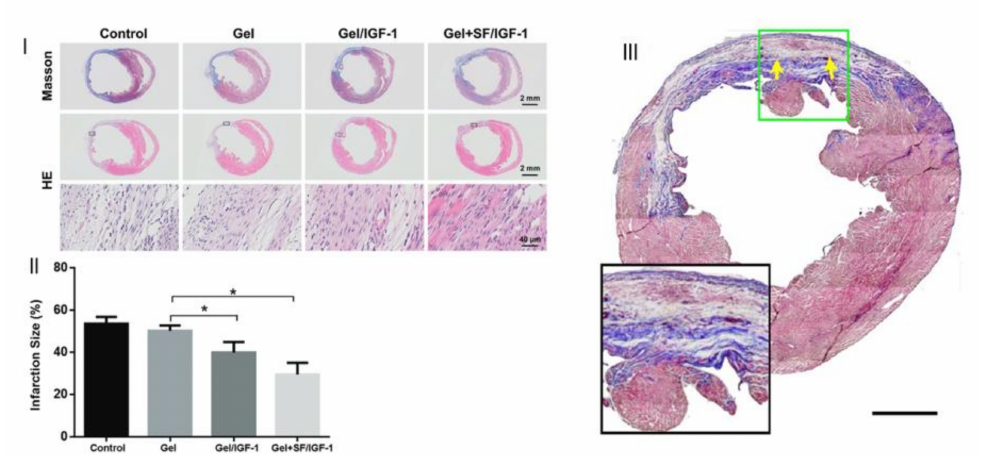
Figure 10. Fibrosis in the infarct area after induction of myocardial infarction. ( I ) Myocardial sections stained with Masson’s trichrome or H&E. ( II ) Statistical analysis of Masson’s trichrome staining 7 d post-MI (note: * p < 0.05). (Adapted with permission from [21]. Copyright (2020) Royal Society of Chemistry). ( III ) Representative Masson’s trichrome stained cardiac cross sections 16 weeks after injection of IGGF-1 loaded system (scale bar 500 µ m). (Adapted with permission from [61]. Copyright (2013) American Chemical Society).